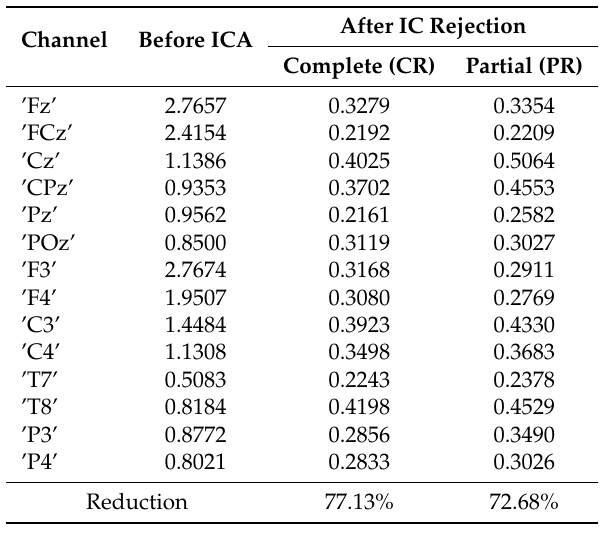
Table 4. Average cumulative cross-correlation coefficients before and after applying the considered artifact processing schemes based on complete/partial IC rejection. Note that all absolute values in this table are divided by 10 5 .